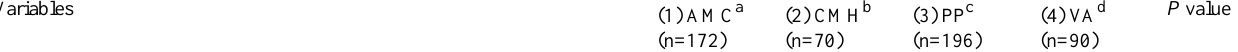
Table 6. Results of chi-squares for practice adjustments and analyses of covariance for patients seen and tele–mental health factors during COVID-19 by